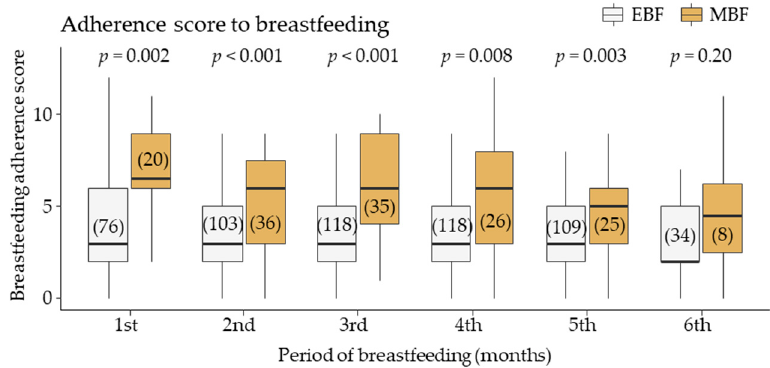
Figure 3. Evolution of breastfeeding adherence score during the breastfeeding period stratified by infant exclusive breastfeeding (EBF) or mixed breastfeeding (MBF). Data show median and interquartile range. Sample size is shown between brackets. The p -Value was obtained by Wilcoxon sum-rank test. Table 2. Correlations between breastfeeding adherence score and psychological factors stratified by the breastfeeding